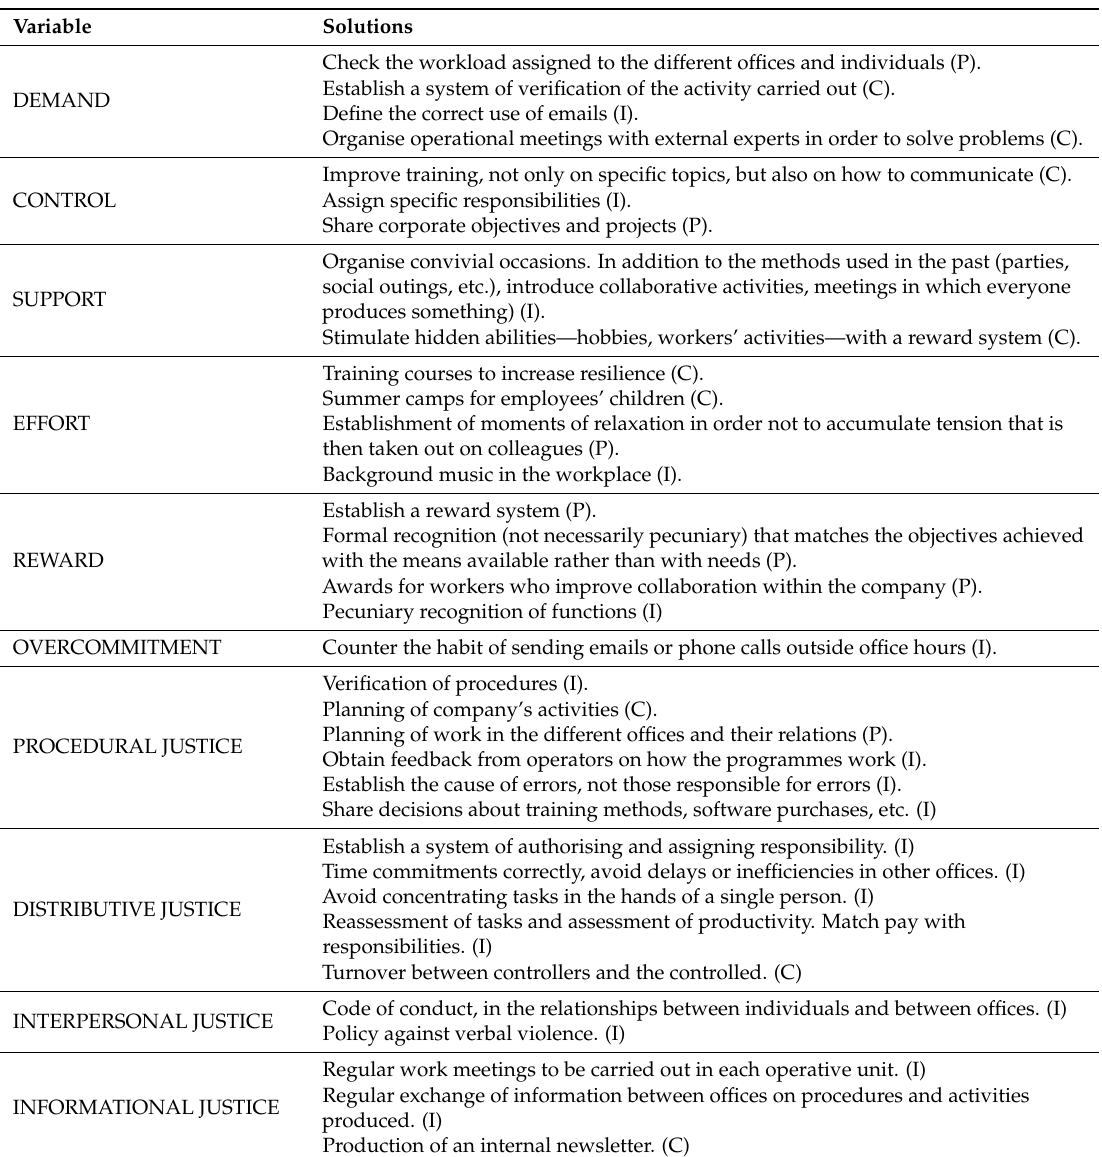
Table 2. Solutions proposed by workers that have been implemented (I), are in progress (P), or will be considered in the future (C) by the